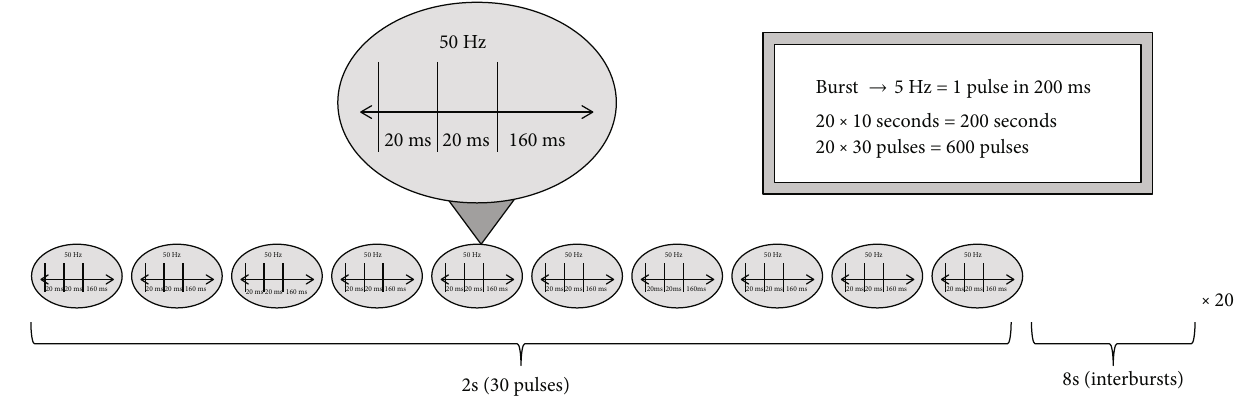
Figure 2: Protocol of intermittent theta burst stimulation. Table 1: Healthy control group: median and interquartile range (IQR) of di ff erence “ before minus after ” of electrical perception test (EPT) of the di ff erent dermatomes C6, C7, and C8 in milliampere. Electrical perception test of di ff erent dermatomes in the control group.